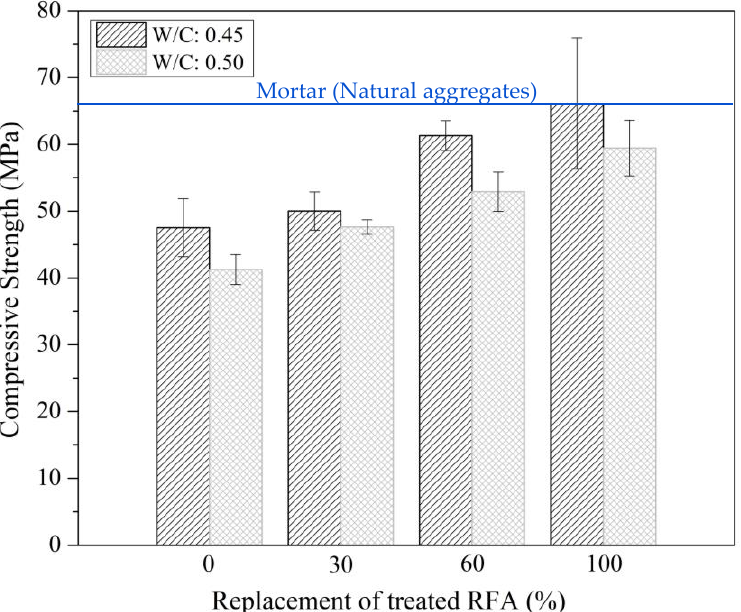
Figure 12. 28-day compressive strength for mortars with different replacement of treated RFA at 0.5mol/L – 7d – 20 °C and natural aggregates.